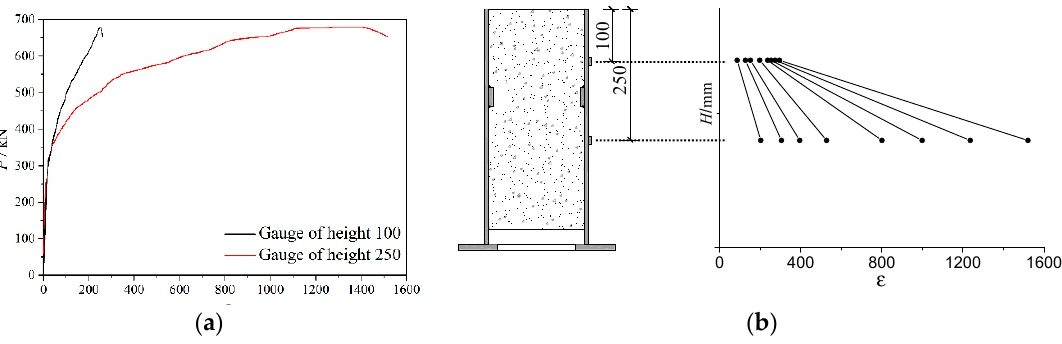
Figure 9. Strain characteristics of specimen P8-8-0-120. ( a ) Load-strain curves; ( b ) Strain distribution.